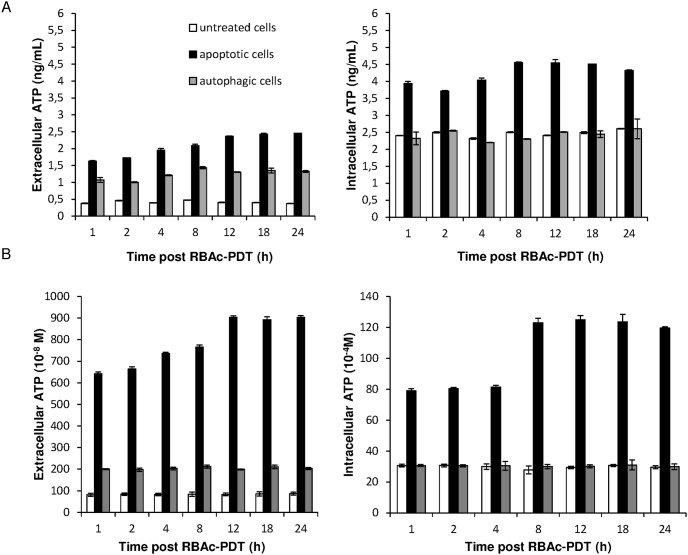
RBAc-PDT induces release of ATP in HeLa cells.Kinetic of intracellular and extracellular released ATP was performed by ELISA (A) and luciferin-luciferase based (B) assay on the conditioned media of RBAc-PDT treated HeLa cells (10−5 M RBAc, 1 h, 1.6 J/cm2, 90 sec) in the presence of 3-MA (10 mM) and Nec-1 (300 µ) (apoptotic cells) and in the presence of z-VAD-FMK (20 µM) and 3-MA (10 mM) (autophagic cells) at indicated time intervals. The amount of ATP, reported as ng/mL or as concentration (M), is the mean ± SD of three independent experiments. The values of extracellular ATP both of apoptotic and autophagic cells are significantly different (p<0.05) with respect to untreated cells. Extracelluar ATP values of apoptotic cells were always significantly different (p<0.05) with respect to autophagic cells. Intracellular ATP values of apoptoticc cells were always significantly different (p<0.05) with respect to autophagic and untreated cells.